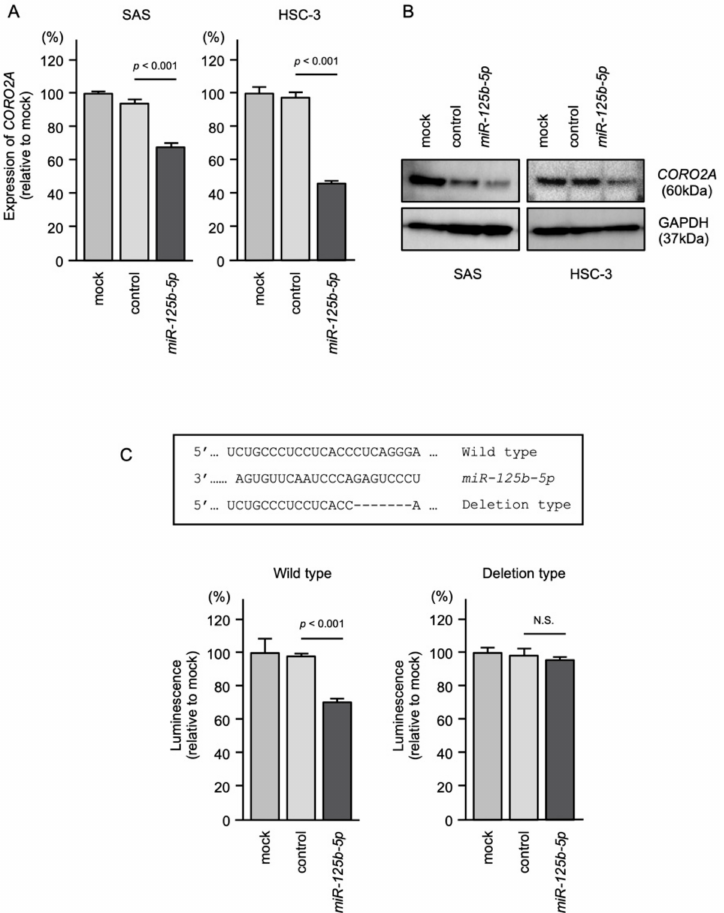
Figure 8. Direct regulation of CORO2A expression by miR-125b-5p in OSCC cells. ( A ) Real-time PCR showing the significantly reduced expression of CORO2A mRNA at 48 h after miR-125b-5p transfec- tion in SAS and HSC-3 cells. Expression of GAPDH was used as an internal control. ( B ) Western blot showing reduced expression of the CORO2A protein at 48 h after miR-125b-5p transfection in SAS and HSC-3 cells. Expression of GAPDH was used as an internal control. ( C ) TargetScan database shows that a single putative miR-125b-5p binding site predicts the 3 (cid:48) UTR of CORO2A sequence (upper panel). Dual-luciferase reporter assays showed reduced luminescence activity after co-transfection of the wild-type vector and miR-125b-5p in HSC-3 cells (lower panel). Normalized data were calculated as the Renilla/firefly luciferase activity ratio (N.S., not significant).